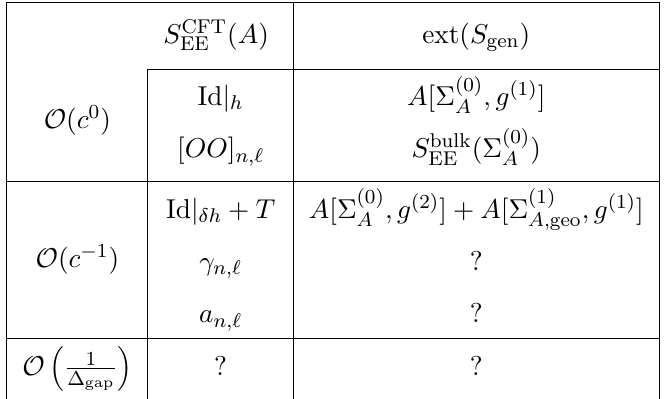
) column correspond to the contribution gen